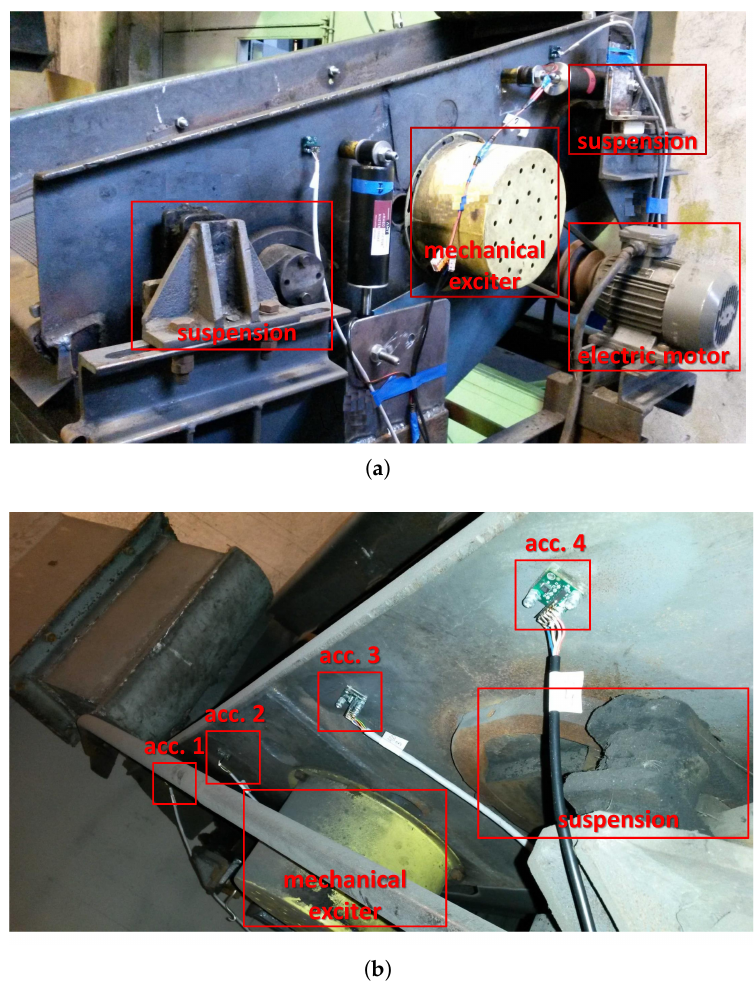
Figure 5. Measurement system applied for identification of screen model: ( a ) mechanical structure of the screen, ( b ) accelerometers attached to the sidewall of the screen riddle at the measurement